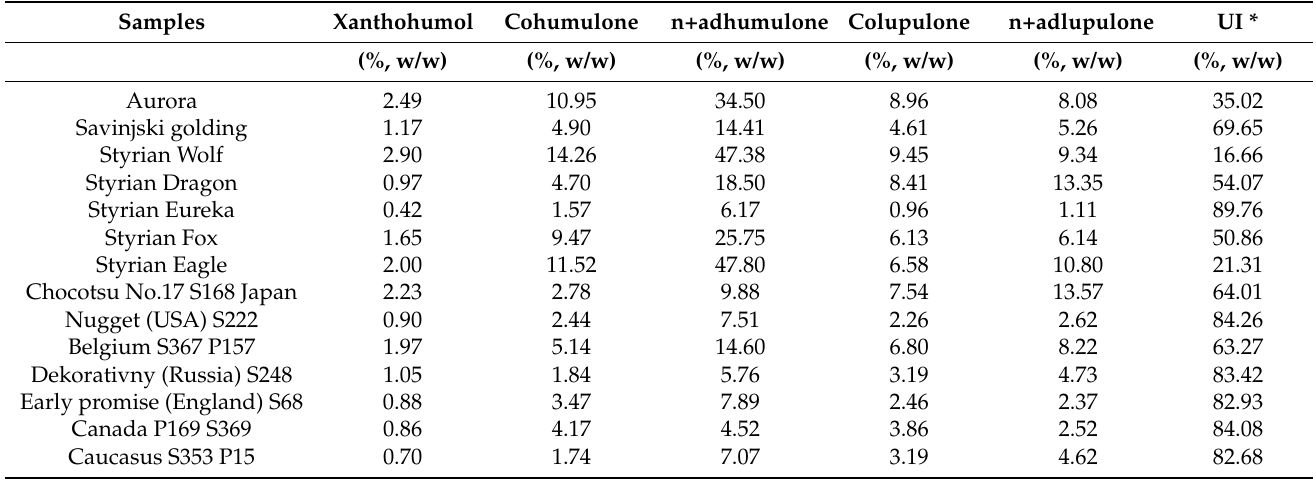
Table 2. The chemical composition of HAE extracts of different hop varieties included in our study, evaluated by HPLC.